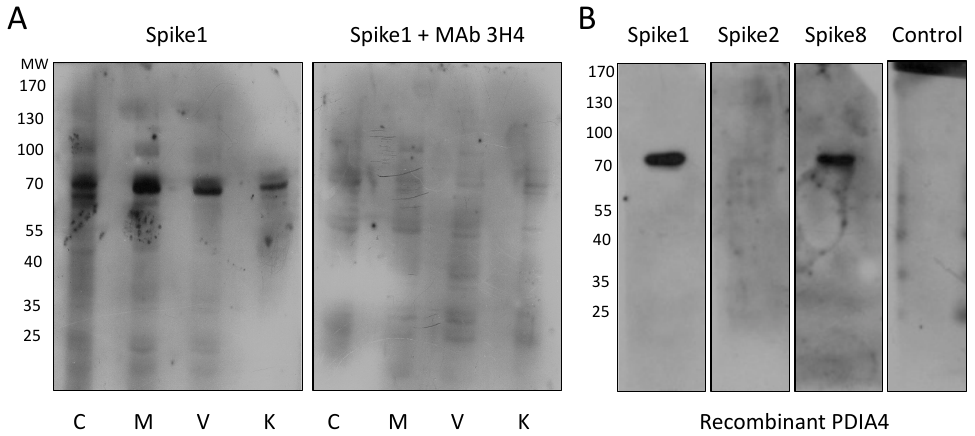
Figure 3. ( A ) A neutralizing monoclonal antibody to HAstV-1 blocks the interaction of spike 1 with the cellular 70–75 kDa proteins. A far-Western assay was performed as described in Material and Methods. Spike 1 was pre-incubated for 1 h at room temperature with or without neutralizing MAb 3H4, then added to the membrane and incubated overnight. The spike bound to cellular proteins was detected with an anti-spike 1 antibody. ( B ) HAstV interacts with PDIA4 in a serotype-specific manner. Recombinant PDIA4 protein (300 ng/lane) was separated by SDS-PAGE and transferred to nitrocellulose membrane and a far-Western assay was performed using the indicated HAstV spikes or without a spike protein as a control. Detection of the corresponding spikes was performed with specific anti-spike antibodies. The molecular weight (MW) is indicated. A representative image from at least three independent experiments is shown. C, Caco-2; M, MA104; V, Vero; K, MDCKII